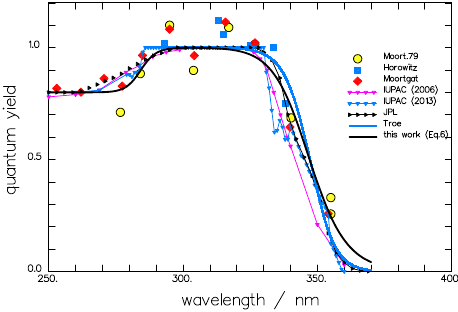
Figure 2. Spectrum of the quantum yield of the total CH 2 O pho- tolysis at room temperature. Measured data used for the fit are in- dicated by the large filled symbols (Moort.79: Moortgat and War- neck, 1979; Horowitz and Calvert, 1978; Moortgat et al., 1983). The present fit and the theoretical curve from Troe (2007) are given by full lines. Recommended data are represented by small sym- bols connected by a thin line: JPL (Sander et al., 2011), and IU- PAC (2006,